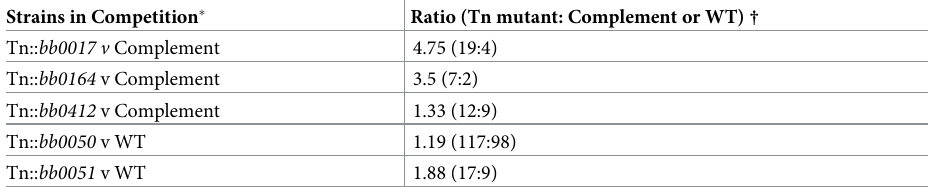
Strains in Competition �